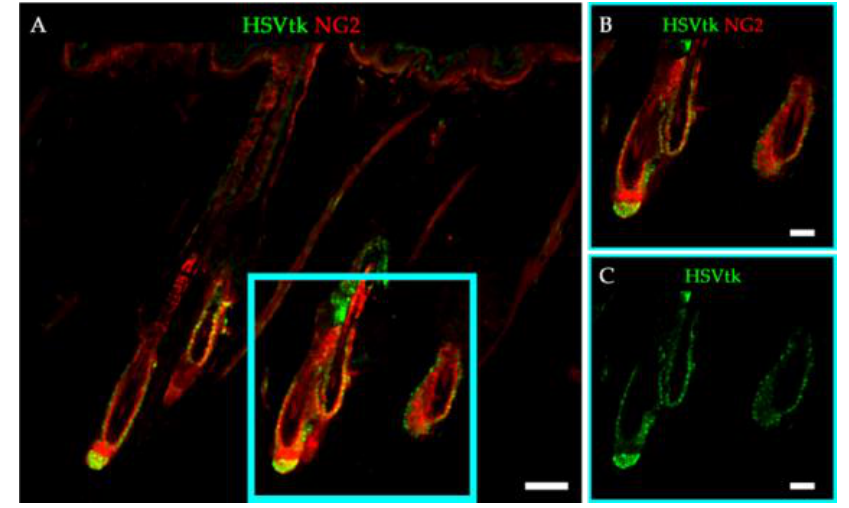
Figure 1. Expression of the HSVtk transgene in NG2 + cells in the hair follicles of NG2-HSVtk Tg rats. ( A , B ) Skin sections of NG2-HSVtk Tg rats stained with HSVtk (green) and NG2 (red) antibodies. ( B ) Magnified images of the area in the light blue square in ( A ). ( C ) Magnified images of immunofluorescence staining for HSVtk (green), shown as the light blue square area in ( A ). Scale bars, 100 μm ( A ), 50 μm ( B , C ).